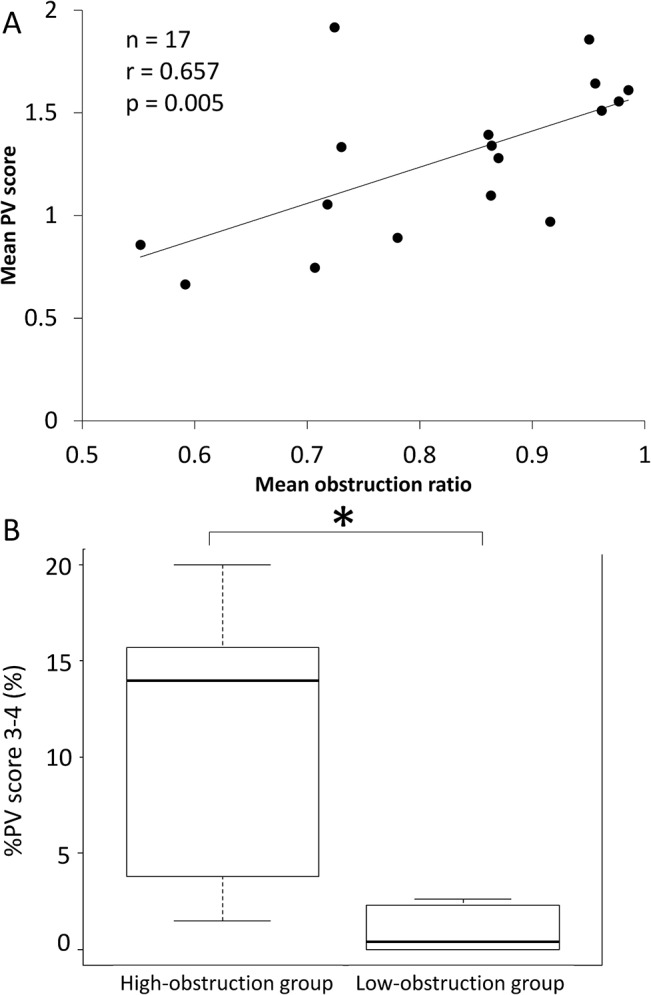
The relationship between the extent of remodeling of the pulmonary arteries and veins.(A) The mean PV score had a significant positive correlation with the mean obstruction ratio (n = 17, r = 0.657, p = 0.005). (B) In the high-obstruction group, the % PV score 3–4 (the fraction of all pulmonary veins with moderate-to-severe alternation) were significantly high compared with the ratio in the low-obstruction group (p = 0.01, analyzed by Wilcoxon’s signed-rank test).